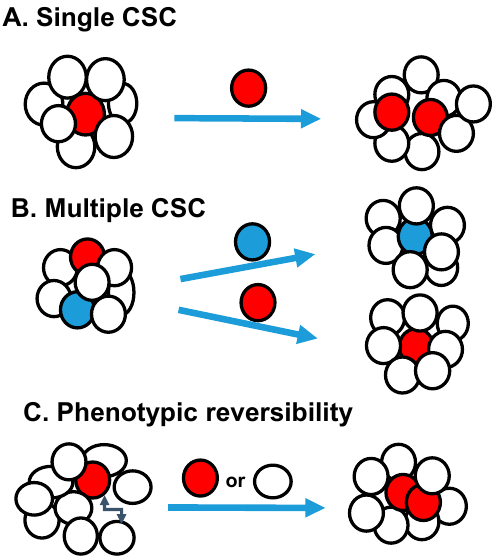
Figure 1. Schematic Models of Tumor Heterogeneity: ( A ) Single CSC pool may be present within the tumor. ( B ) Multiple distinct CSC pools with in individual tumors. ( C ) The CSC can be unstable, resulting in phenotypic reversion of cell-surface markers and CSC phenotype.